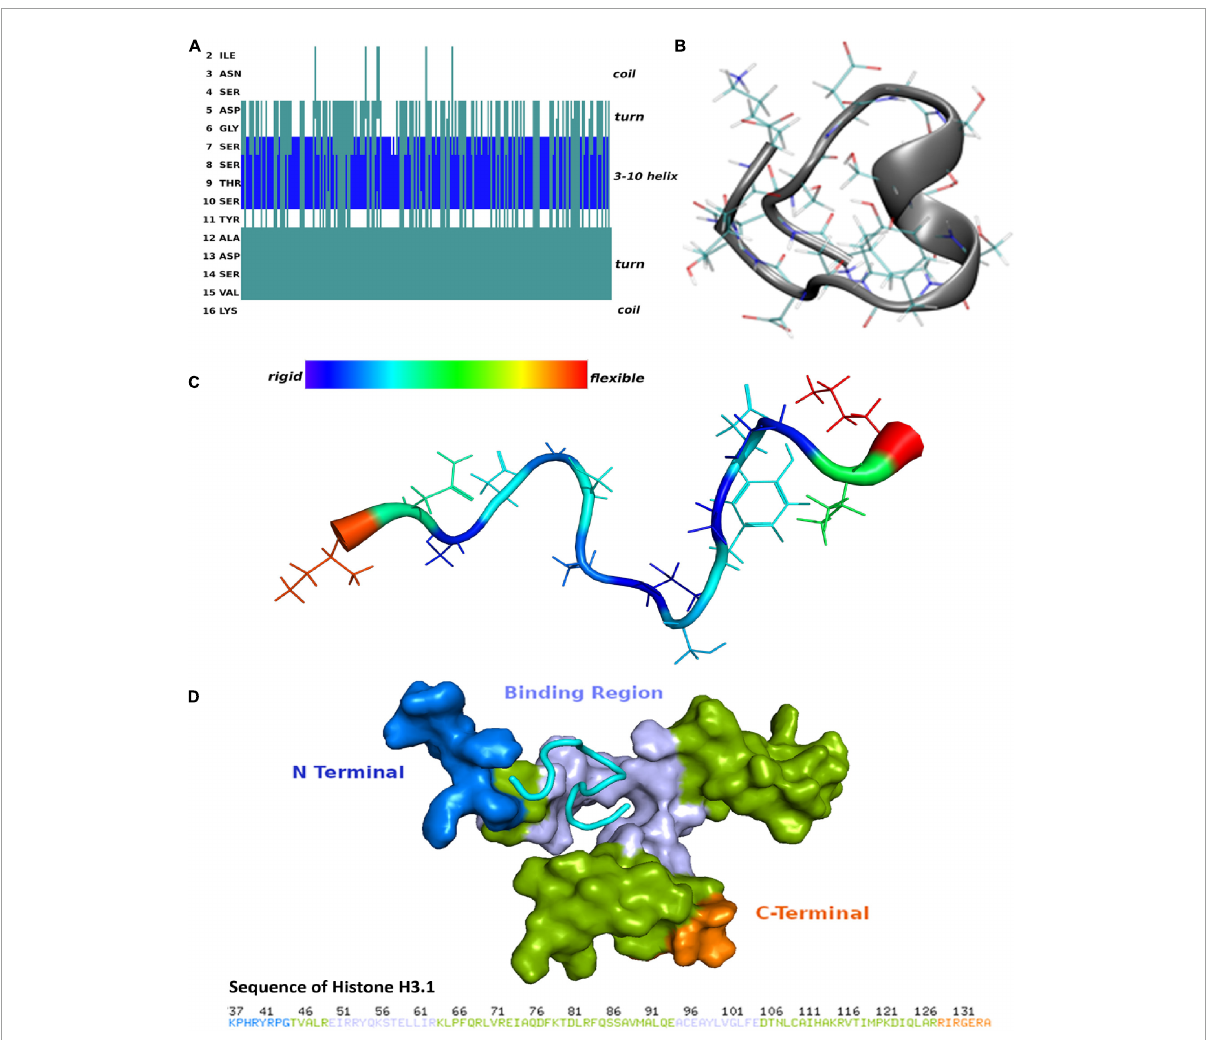
FIGURE2 Secondary structure of the complementary-determining region 2 (CDR2) peptide (INSDGSSTSYADSVK) and prediction of potential binding sites to retinal target protein histone H3.1 (HIST1H3A). (A) Structuring of the CDR2 peptide revealed by the molecular dynamics (MD) simulations. (B) Secondary structure of the CDR2 peptide showing a rigid 3–10 helix portion. The central helical region is formed by the amino acids 5 DGSSTSY 11 . (C) Flexibility of the CDR2 peptide though peptide backbone fluctuations during MD simulations. The central helical regions including the turns show a rigid structural behavior, whereas the coil parts of the peptide indicate a high flexibility. (D) Potential binding site of the CDR2 peptide to target protein HIST1H3A from molecular docking calculations. The peptide interacts with the N-terminal part [from E (50) to R (63)] as well as with the C-terminal region [A (95) to E (105)] of protein HIST1H3A (PDB protein structure: 2CV5; chain: C).